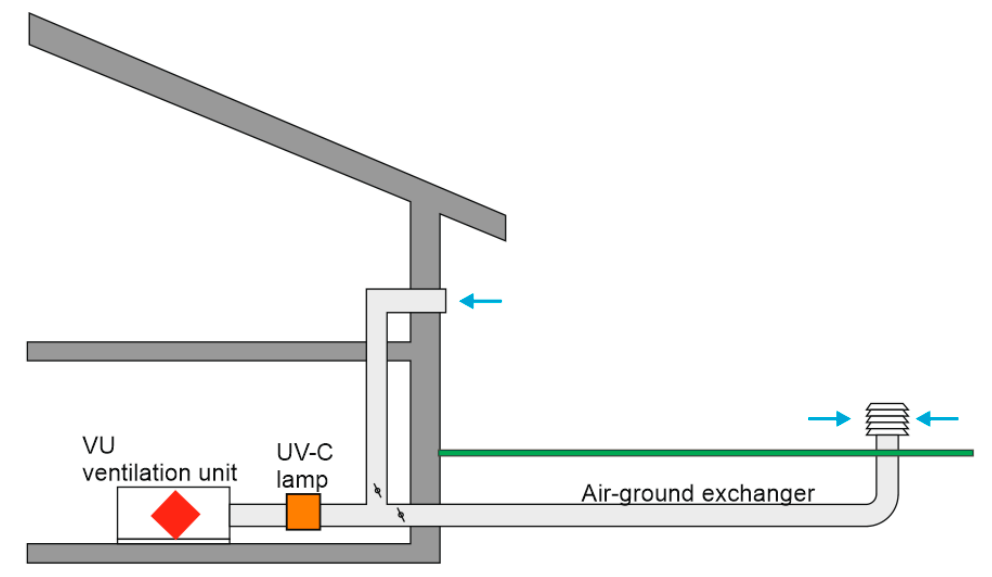
Figure 1. Diagram of an air–ground heat exchanger equipped with a UV-C lamp.